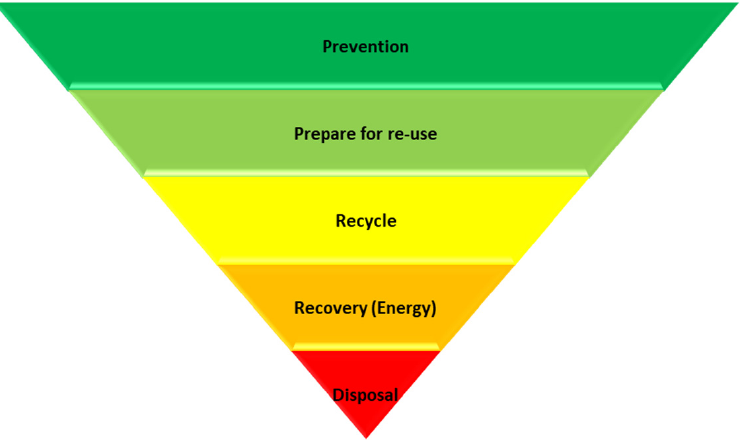
Figure 2. Waste hierarchy adapted from [43].